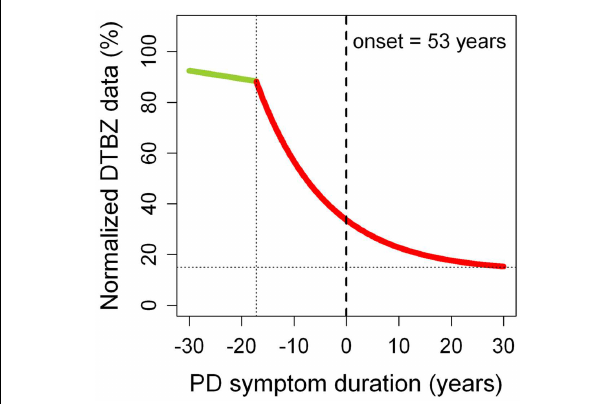
FIGURE 1 | Progression of putaminal dopaminergic (DA) dysfunction in Parkinson’s disease (PD) . DA dysfunction was estimated using normalized [ 11 C]dihydrotetrabenazine (DTBZ) binding data.The green straight segment represents normal aging.The red curve corresponds to PD. Motor symptoms begin at time 0 (in this case, at age 53years, which was the mean age of PD onset of the sample). A very similar PD curve was obtained for the caudate nucleus (10).These observations suggest that the nigrostriatal and mesolimbic dopamine pathways probably have the same pattern of neurodegeneration. It remains unknown whether the same applies to the mesocortical dopamine pathway. Adapted from Ref. (17).